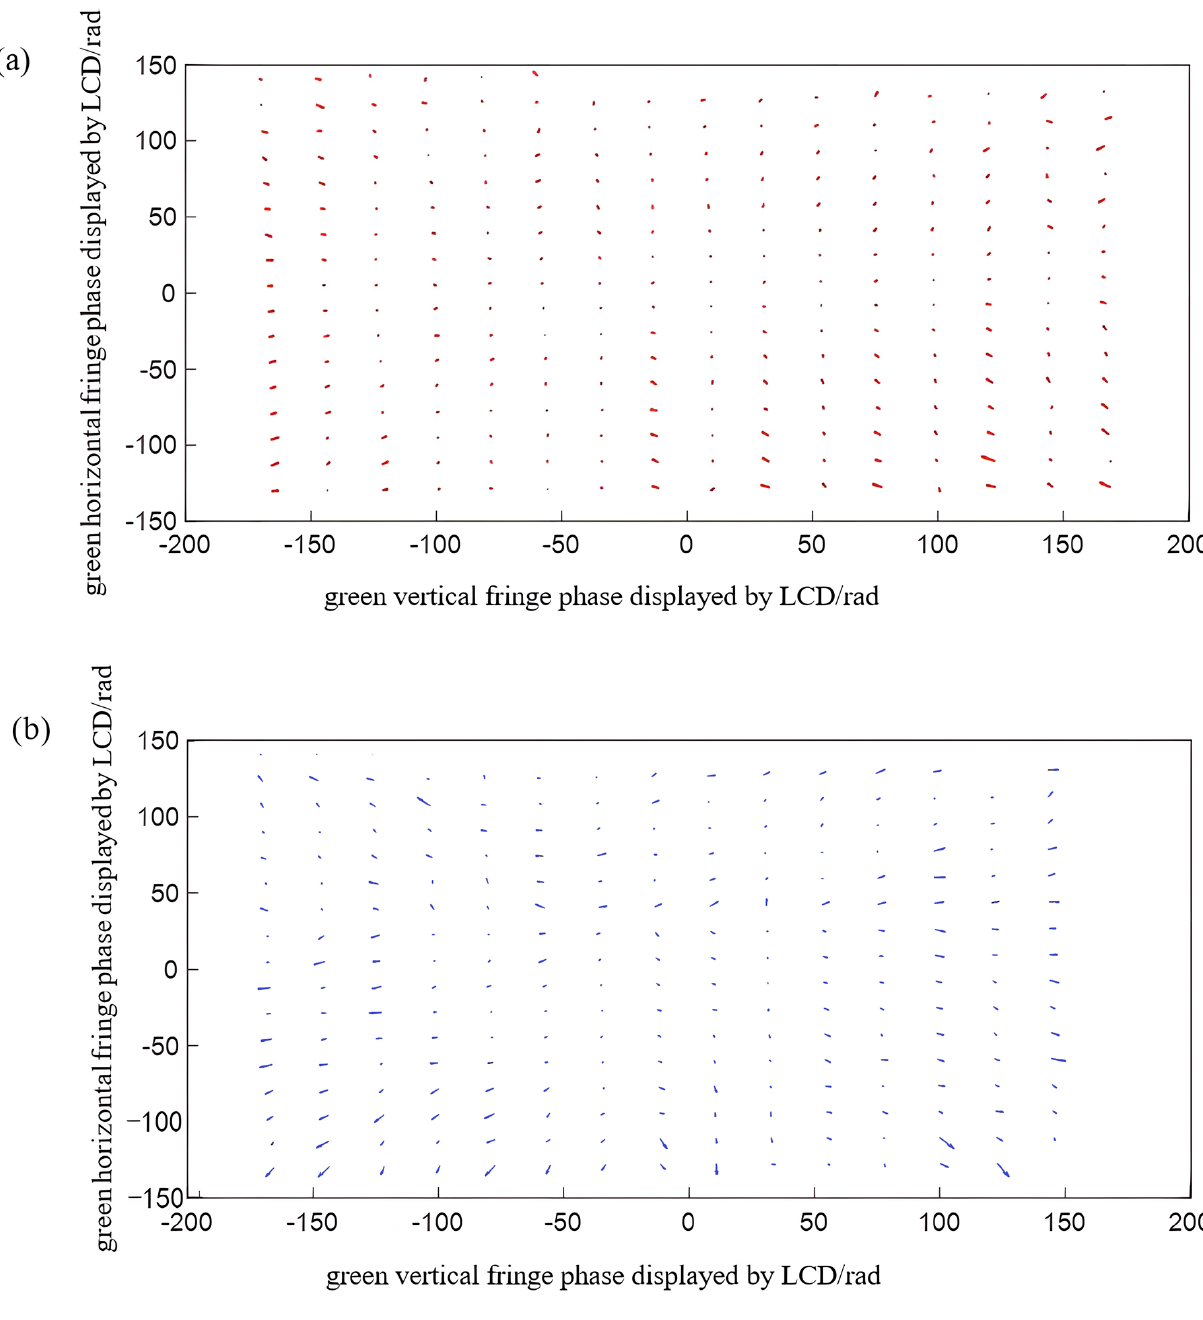
Figure 14. Radial chromatic aberration vector diagram of projector after re − projection: ( a ) vector change diagram of the red and green channels; ( b ) vector change diagram of the blue and green channels.